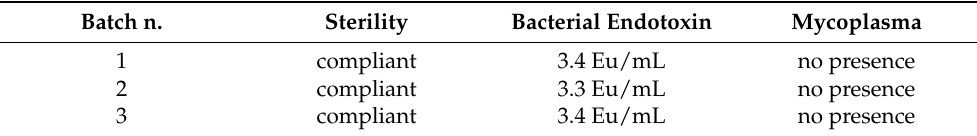
Table 2. Lyosecretome microbiological test: Sterility, bacterial endotoxin, and Mycoplasma. Batch